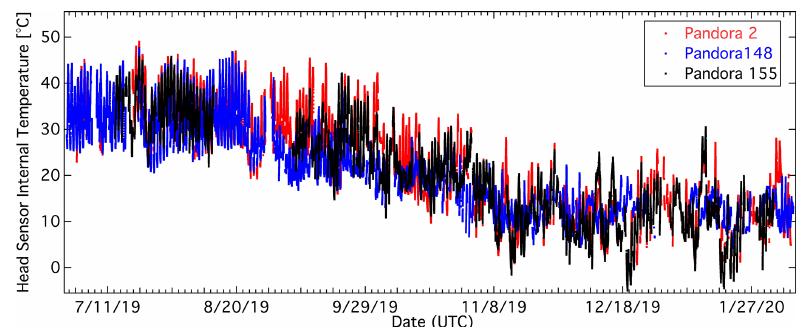
Figure 4. Internal head sensor temperatures for Pandora 2 (Greenbelt, MD), 148 (Blacksburg, VA; Rotterdam and Cabauw, the Netherlands) and 155 (Boston,